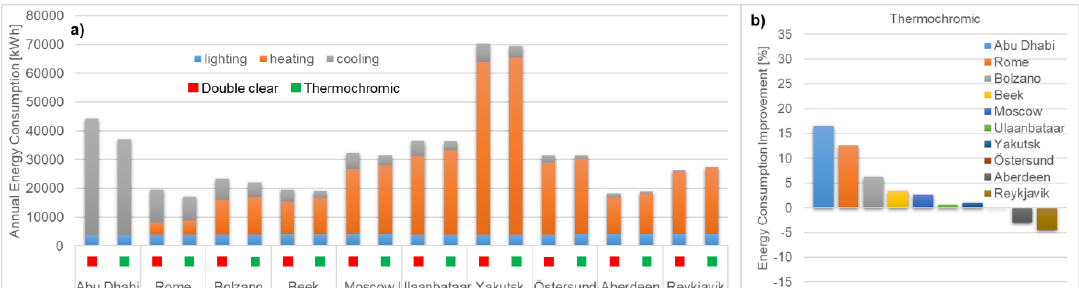
Figure 9. ( a ) Annual energy consumption due to lighting, heating and cooling of a residential building equipped with double clear or thermochromic glazing at various locations; ( b ) annual energy consumption improvement of thermochromic glazing in comparison to clear glass for various locations.